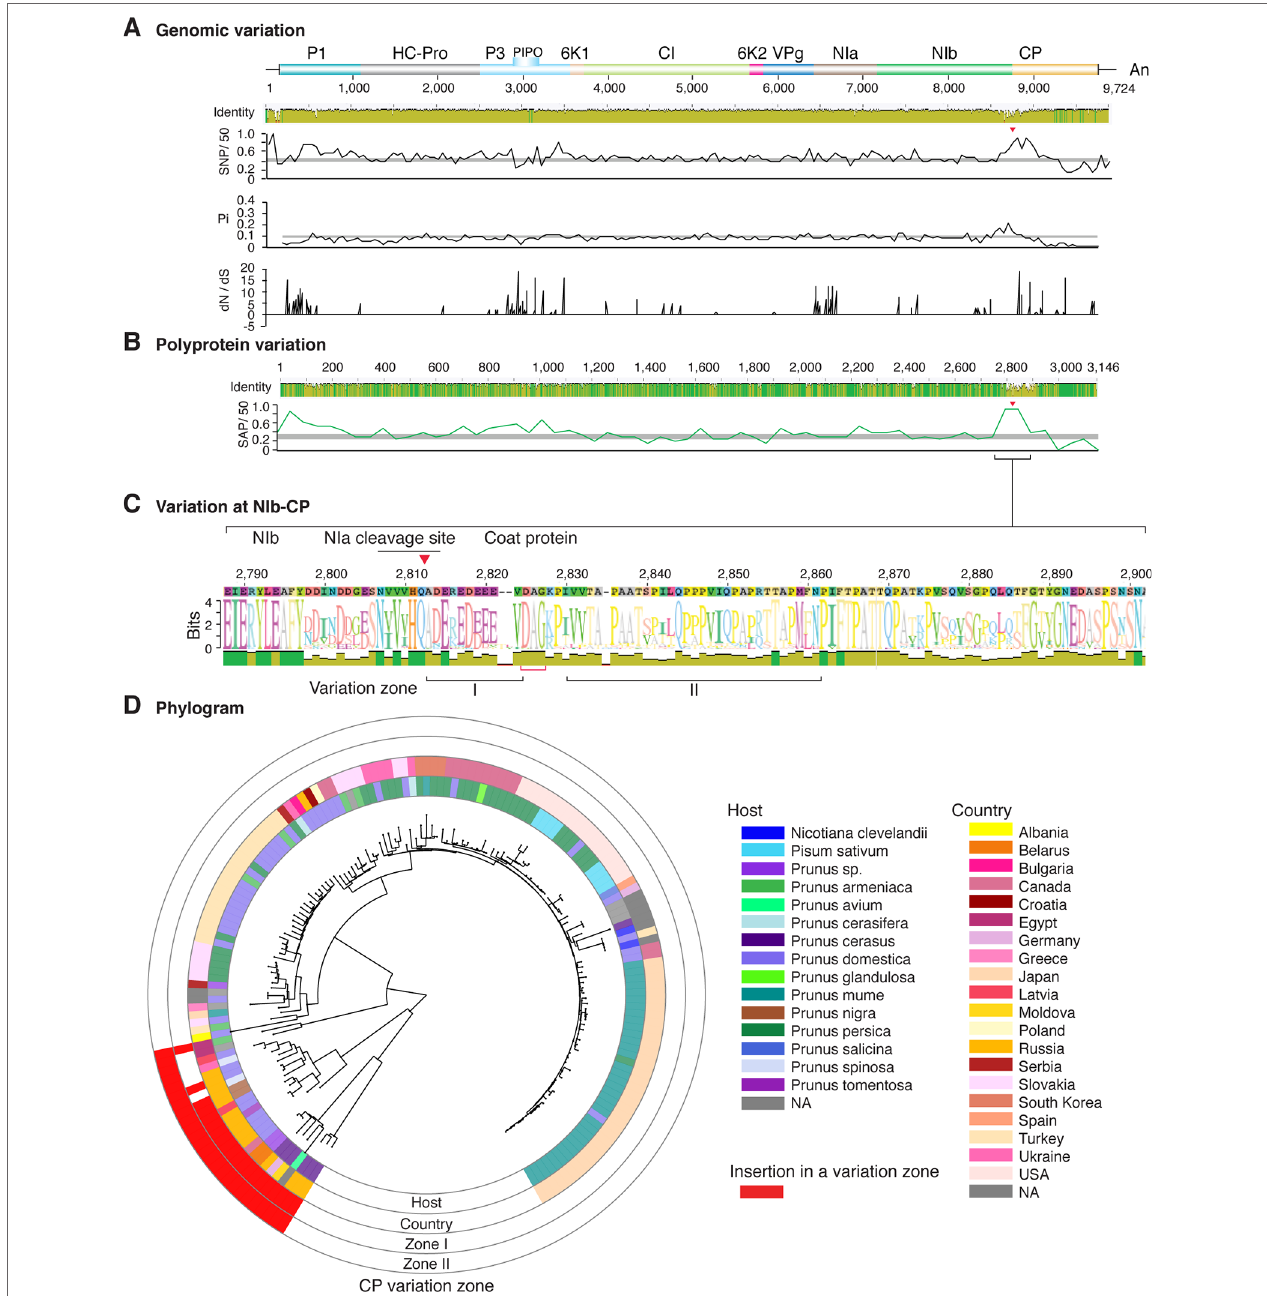
FiGUre 5 | Nucleotide and polyprotein variation in plum pox virus. Genome organization is shown to scale using accession MF370984.1 as reference. Labels are as in Figure 2 .